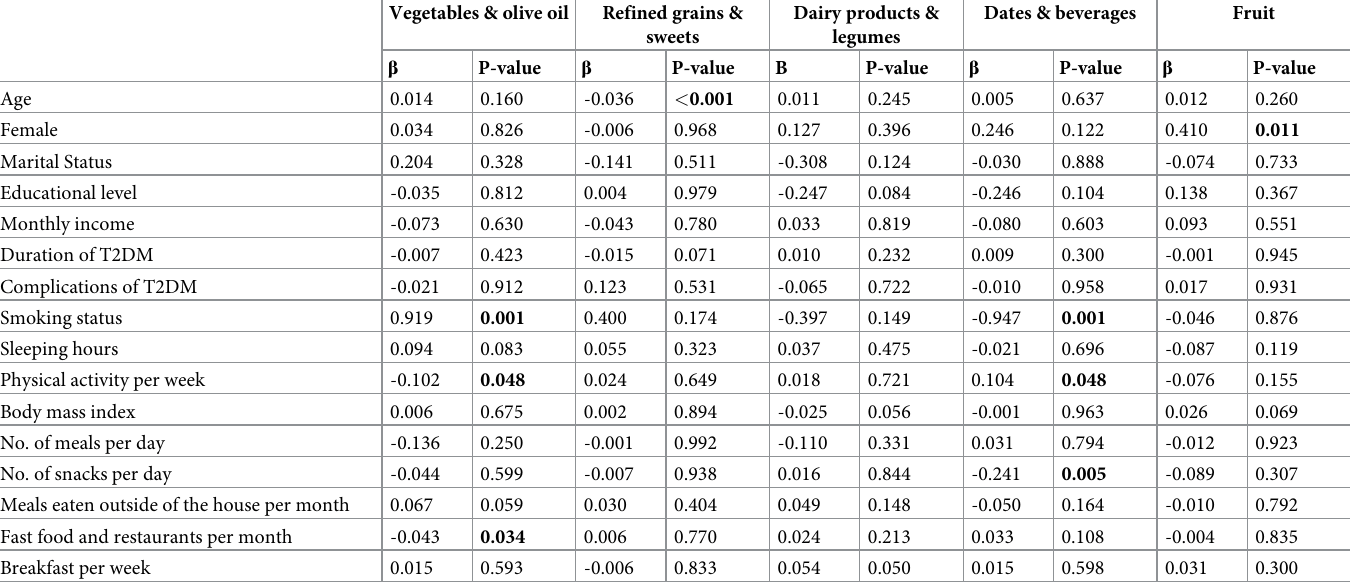
Table 5. Association between sociodemographic and lifestyle characteristics and dietary pattern a